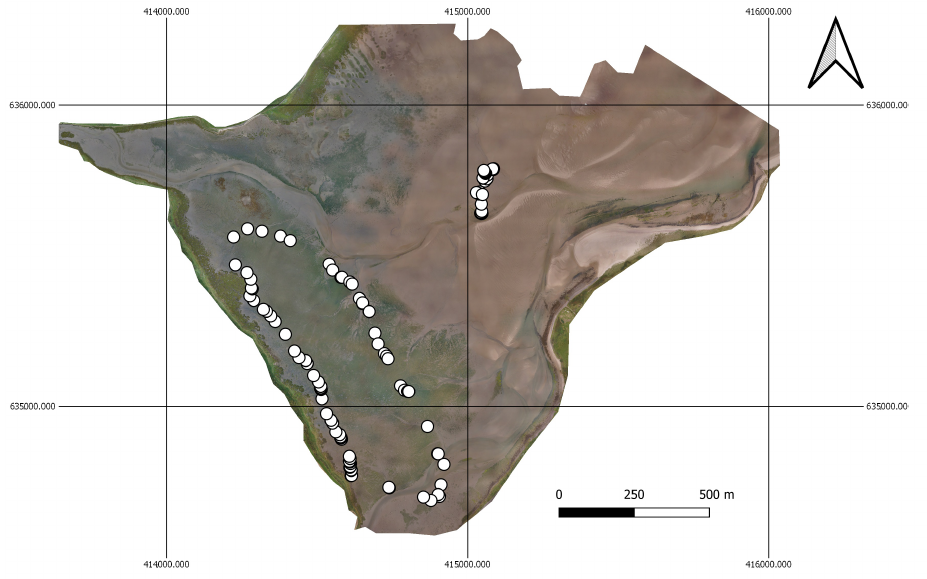
Figure 2. Distribution of recorded tags during the on-situ